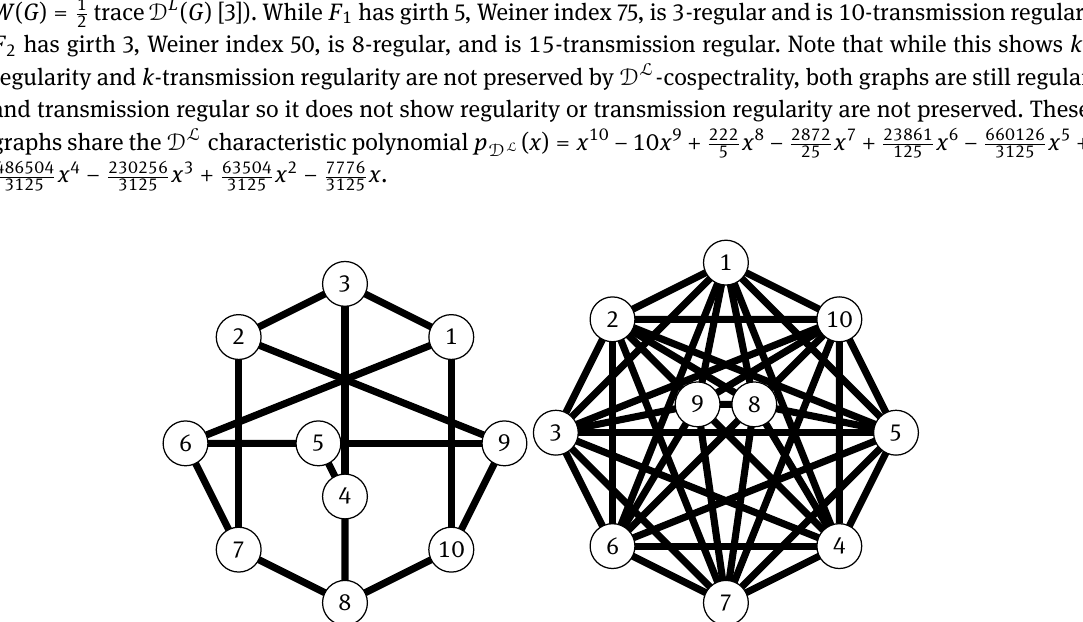
W ( G ) = 1 trace D L ( G ) [3]). While F 1 has girth 5, Weiner index 75, is 3-regular and is 10-transmission regular, 2